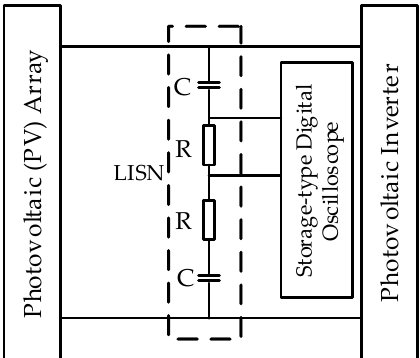
Figure 2. DC-side noise measurement scheme of photovoltaic power station inverter.